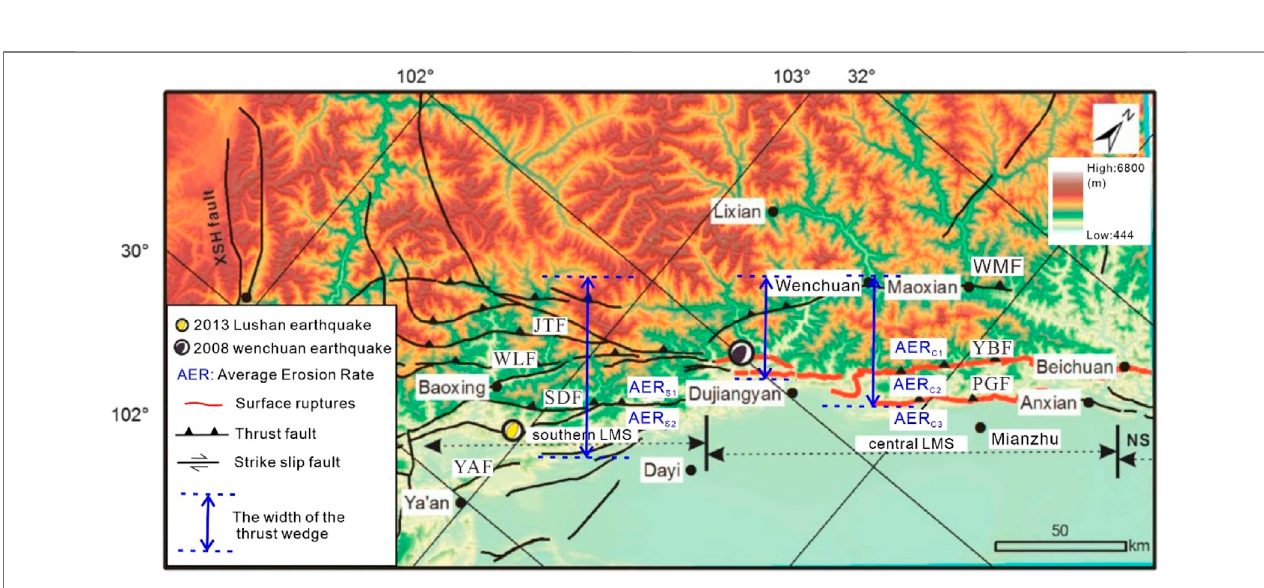
FIGURE 12 | Map of the active faults in the central and southern LMS (modi fi ed from Gao et al., 2016). AER data (AER C1 , AER C2 , and AER C3 are decreasing successively in the central LMS; AER S1 is bigger than AER S2 in the southern LMS) from Figure 2 and Figure 3 in this paper. WMF, Wenchuan-Miaoxian Fault; YBF, Yingxiu-Beichuan Fault, PGF, Pengxian-Guanxian Fault; JTF, Jiatang Fault; WLF, Wulong Fault; SDF, Shuangshi-Dachuan Fault; YAF, Ya ’ an Fault.